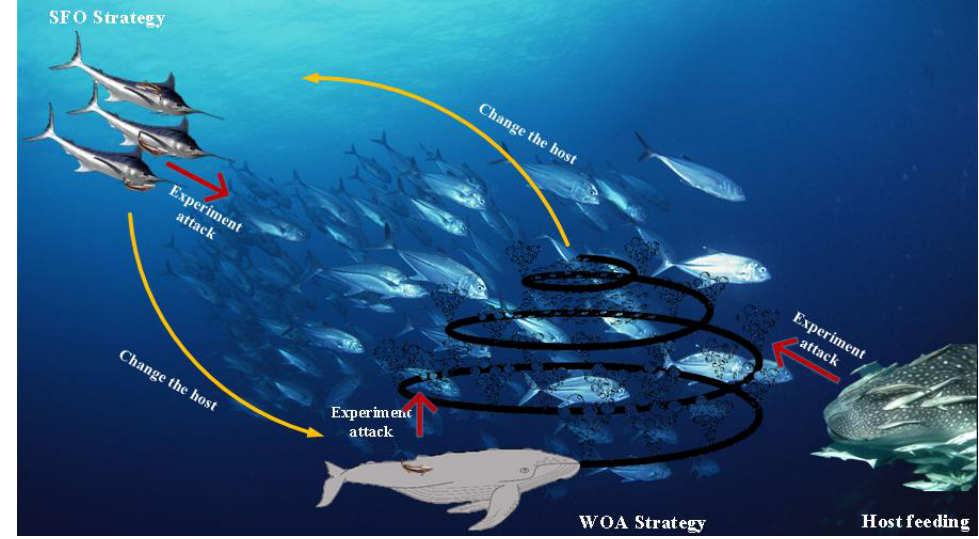
Figure 1. The different states of ROA.